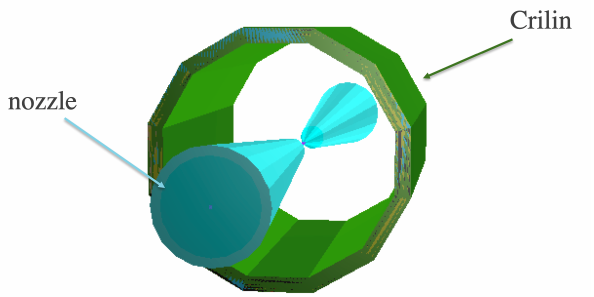
Figure 2. Geant4 realisation of Crilin using a dodecahedra geometry together with nozzles. A Particle Flow algorithm [2], not yet fully optimized, was employed for jet reconstruc- tion. The full simulation of b -jets has been used for this purpose, and the beam-induced background as been simulated as well. The jet reconstruction efficiency and jet p T resolu- tions are presented in Figure 3. It can be noticed that the performance is similar in the two cases but, at the same time, the money cost of Crilin is a factor 10 less.